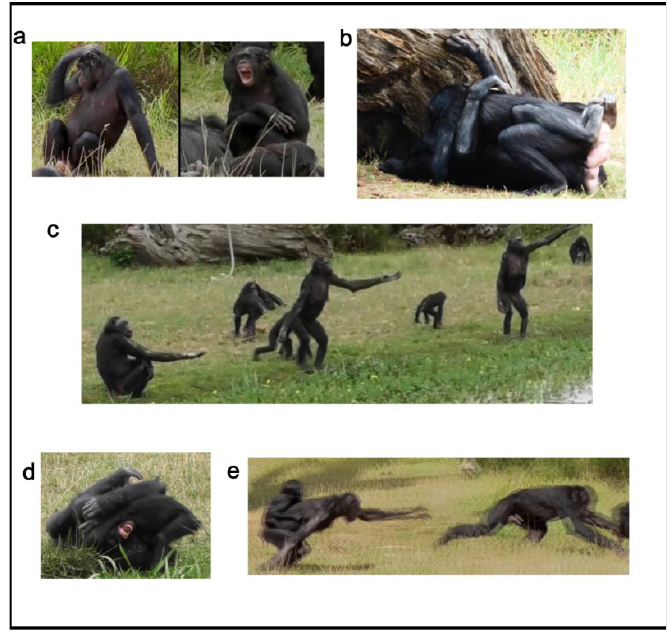
Figure 1. Behavioral patterns considered for this study. ( a ) Anxiety behavior (scratching and yawning); ( b ) sociosexual behavior (genito-genital rubbing between two females); ( c ) requesting gestures; ( d ) play behavior; ( e ) agonistic